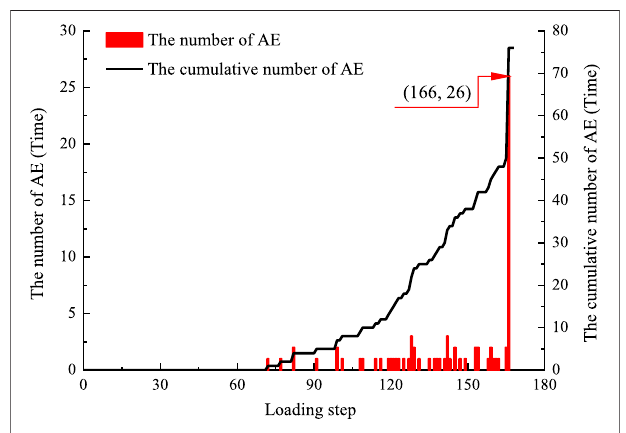
FIGURE 13 | AE curve of anchored rock with the positive Poisson ’ s ratio